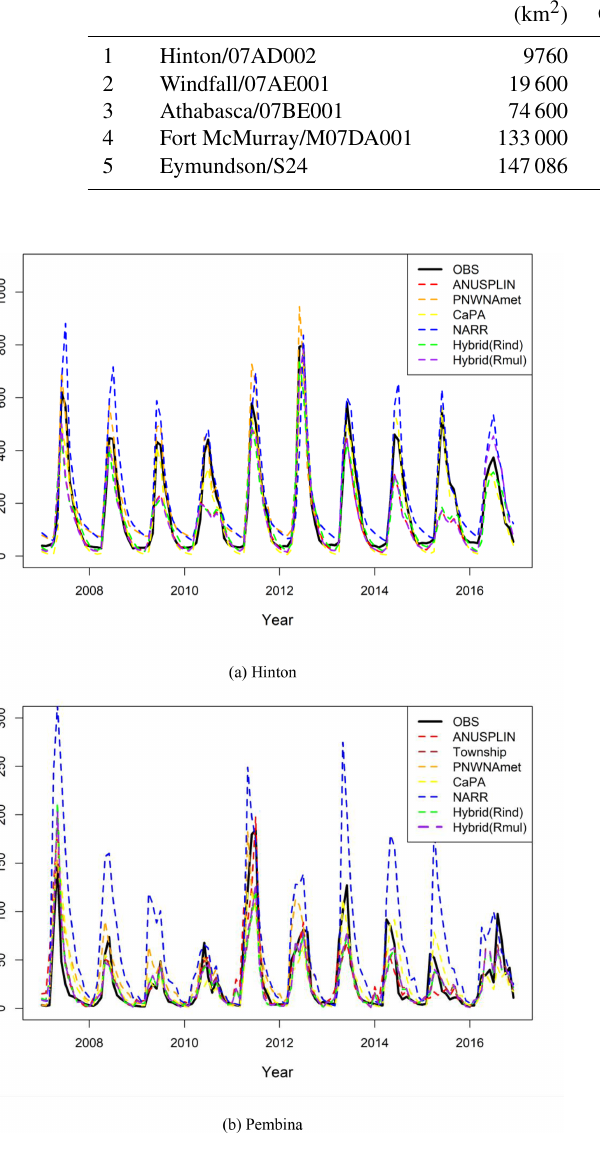
Figure 12. Monthly observed and simulated hydrographs from the gridded climate datasets at (a) Hinton and (b)